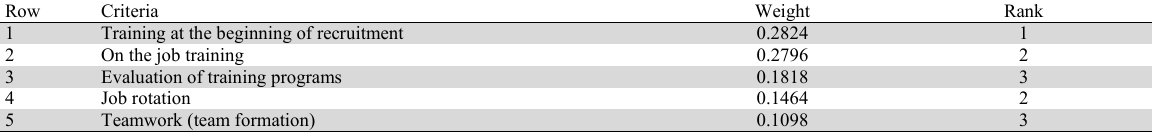
Ranking of training and development sub-criteria